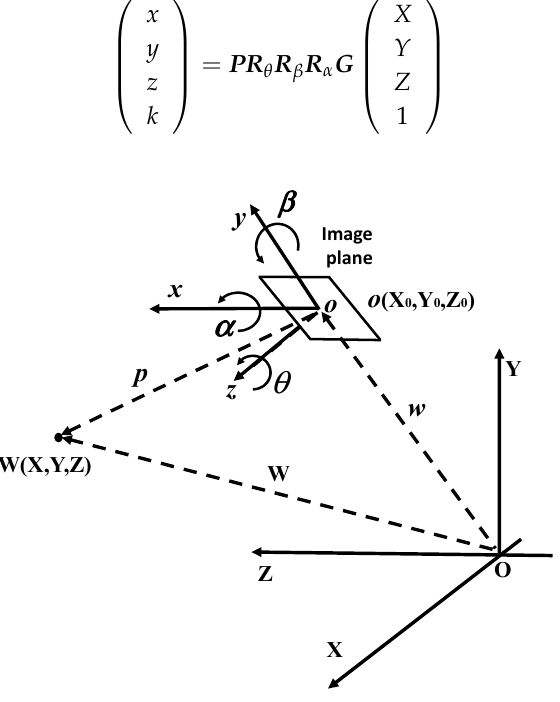
Figure A1. Reference systems and relations.